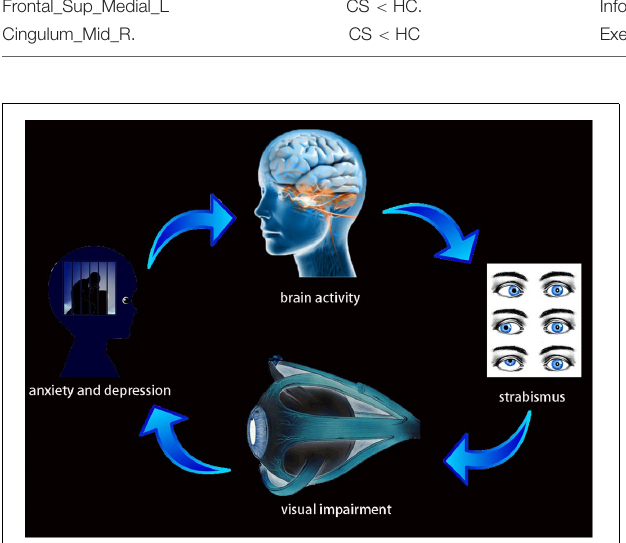
FIGURE 5 | Relationship between MRI images and clinical manifestations in CS. Strabismus results from extraocular muscle dysfunction, leads to visual impairment, further result in anxiety and depression and alterations in brain